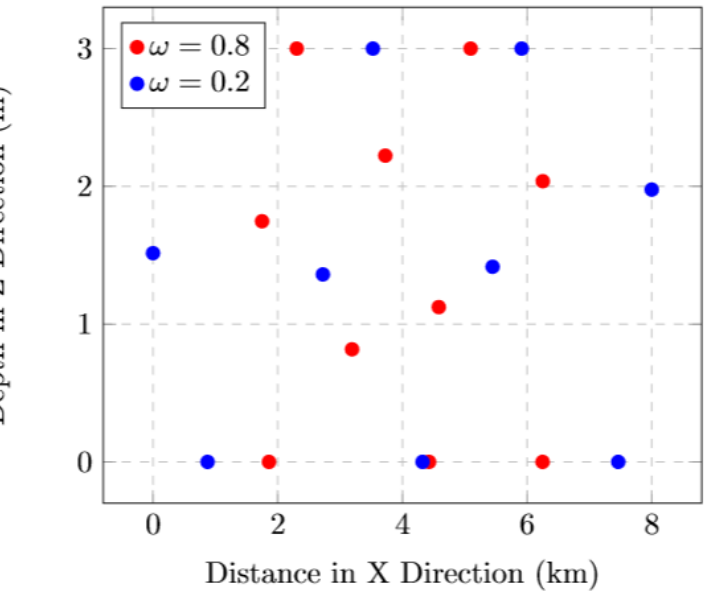
Figure A3. Final positions for an alternative environment, namely with ω = 0.8 and ω = 0.2 and 10 sensors.